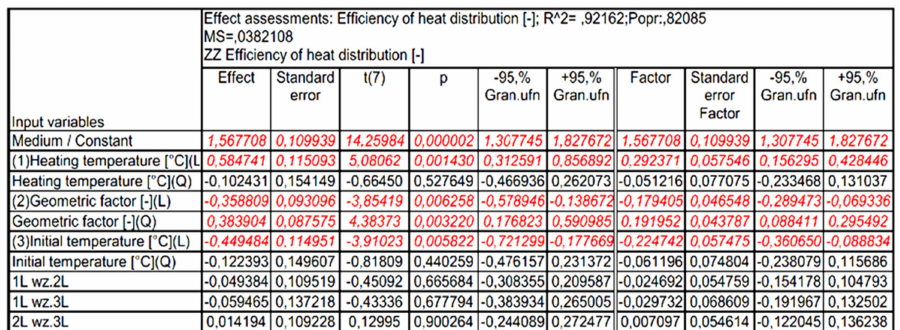
Figure 16. Summary of independent variable assessments on the baseline quantity.